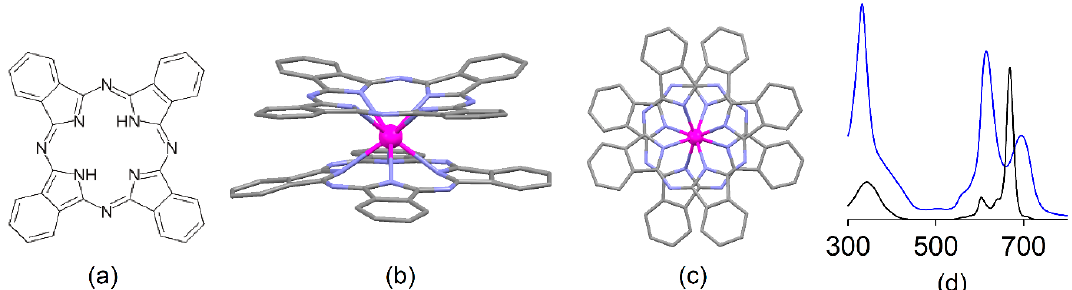
Figure 1. Free-base phthalocyanine, H 2 Pc ( a ); general molecular structure of LnPc 2 ( b ) and top view ( c ); electronic absorption spectra of LuPc 2 (blue line) and ZnPc (black line) in DMF ( d ).